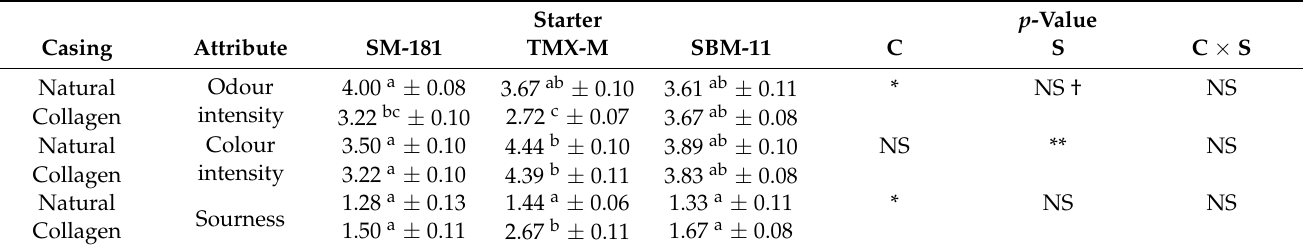
Table 4. Sensory analysis attributes characterised by significant variations in relation to the type of samples (odour intensity, colour intensity and sourness). The mean values of the scores for each attribute are reported. Also, standard errors are reported. The results of a two-way ANOVA are also reported to evaluate the effects of the different experimental conditions and their interactions on sensory evaluation. Differences were considered significant at p ≤ 0.05.